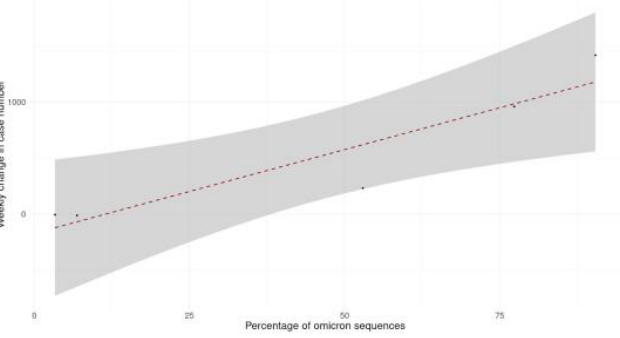
Figure 2. ( A ) Prevalence of the Omicron variant in Mexico City from 16 November to 31 December 2021 (week 45 to week 52). ( B ) Percentage of Omicron variant cases and symptom onset dates. ( C ) Correlation plot between the weekly growth rate of the epidemic curve and the proportion of Omicron variants in 4296 samples from SINAVE.